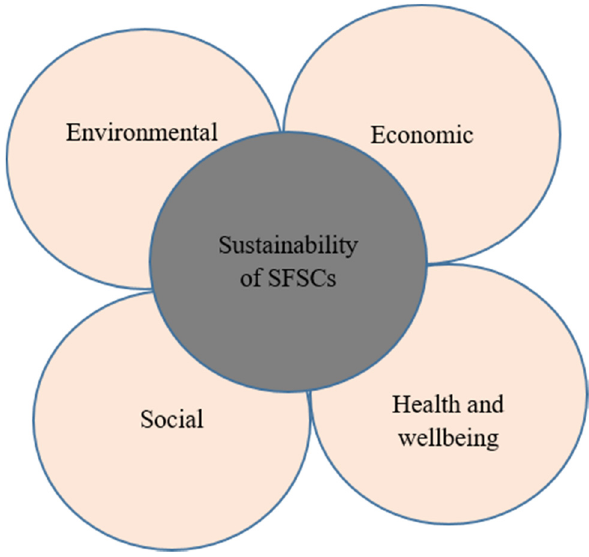
Figure 2: Sustainability of SFSCs. Source: Adapted from Galli and Brunori ( 2012 )